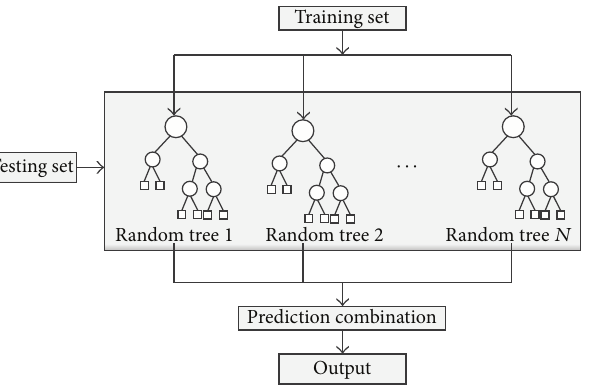
Figure 3: Random forest based